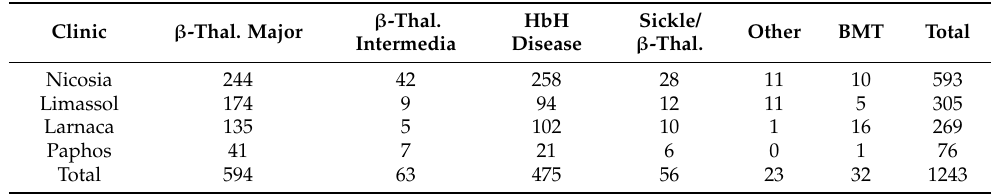
β -Thal. HbH Sickle/ Other BMT Total β -Thal. Intermedia Disease